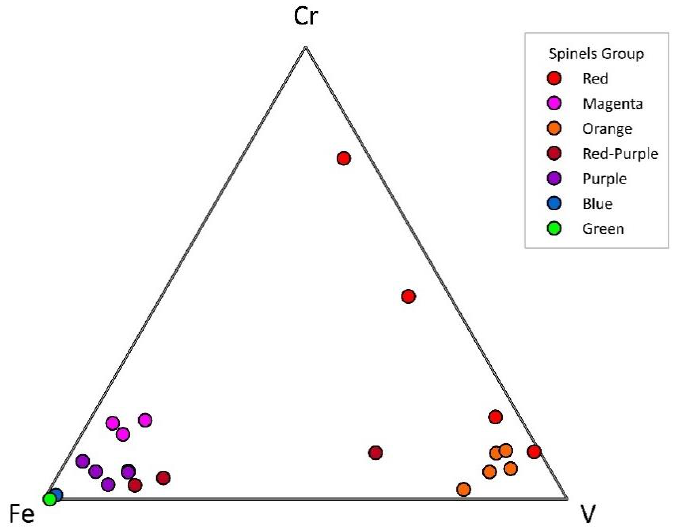
Figure 7 . Ternary plots of Fe - Cr - V of spinel samples showing atomic ratios involving color